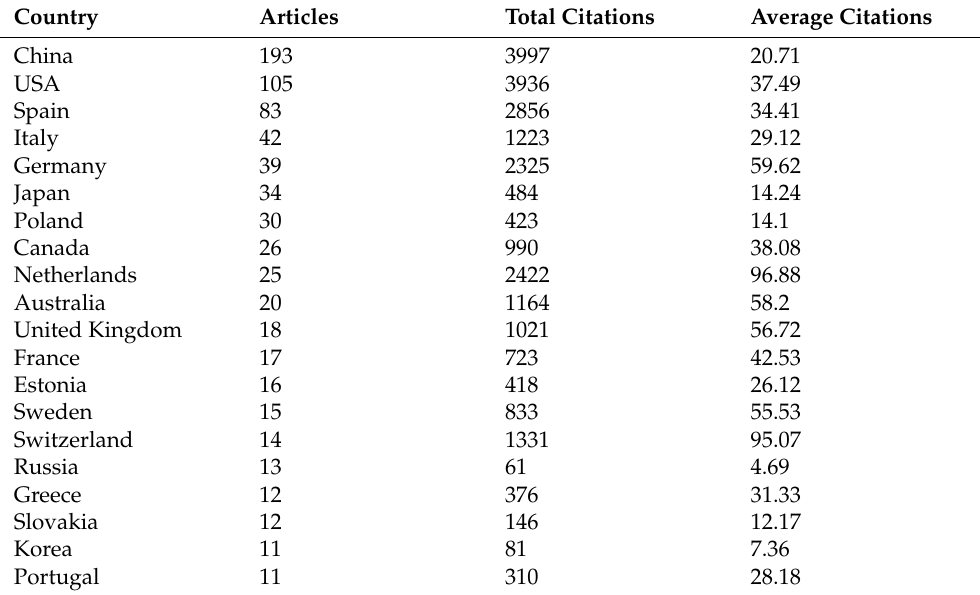
Table 3. Numbers of publications and citations on farmland abandonment in different countries from 1980 to